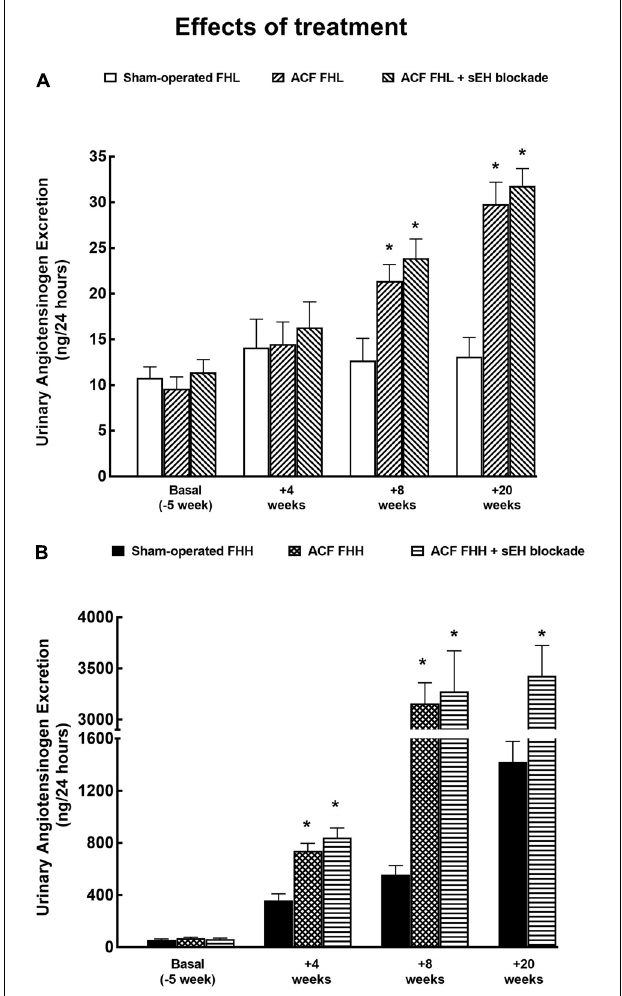
FIGURE 5 | (A) Urinary angiotensinogen excretion in sham-operated fawn-hooded low-pressure rats (FHL) with ACF and ACF FHL rats treated with a sEH inhibitor. (B) Urinary angiotensinogen excretion in sham-operated fawn-hooded hypertensive (FHH) rats, untreated and treated with sEH inhibitor. ∗ P < 0.05 compared with sham-operated counterparts at the same time